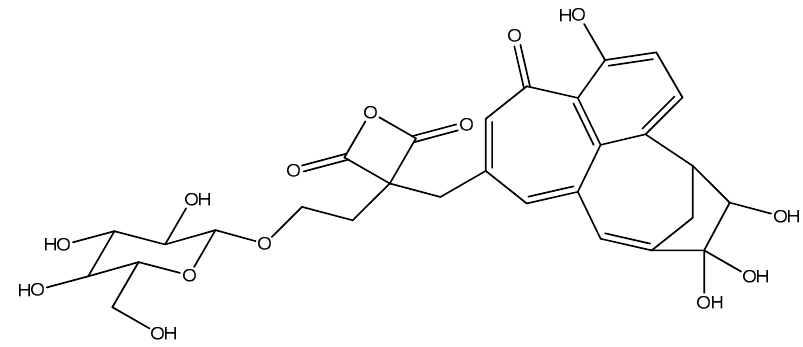
Figure 9. The chemical structure of perseorangin.